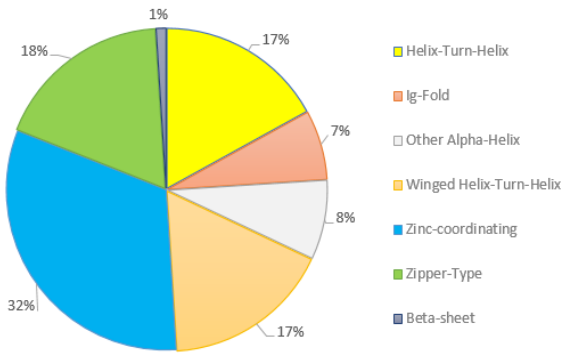
Figure 2. Classes of 116 putative expressed TFs in bovine endometrial epithelial cells. Additionally, genes encoding multiple TFs were identified among the differentially expressed genes associated with cell proliferation. These transcription factors, including TP53 , STAT , E2F , MYC , AP-1 , NFKB , and MYB , are essential in either proliferation or apoptosis processes. In addition, RNASeq reads revealed that JunB , JunD , Foxp4 , and Ets2 were particularly overexpressed in the epithelial cells. We found that the